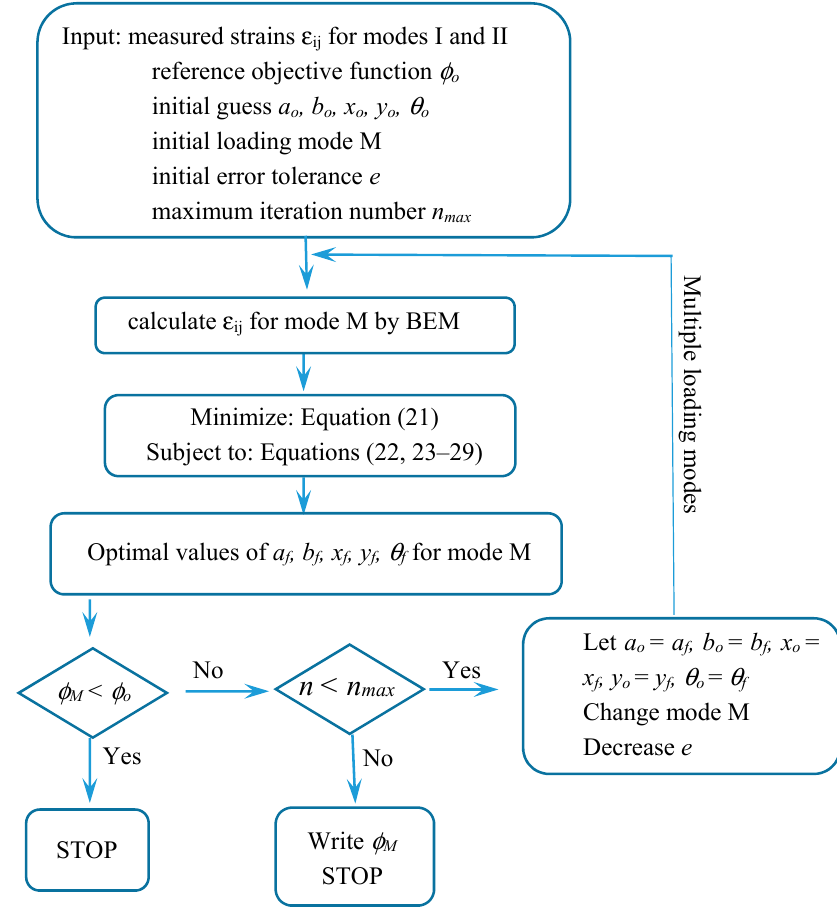
Figure 3. Flowchart of nonlinear optimization with multiple loading modes.